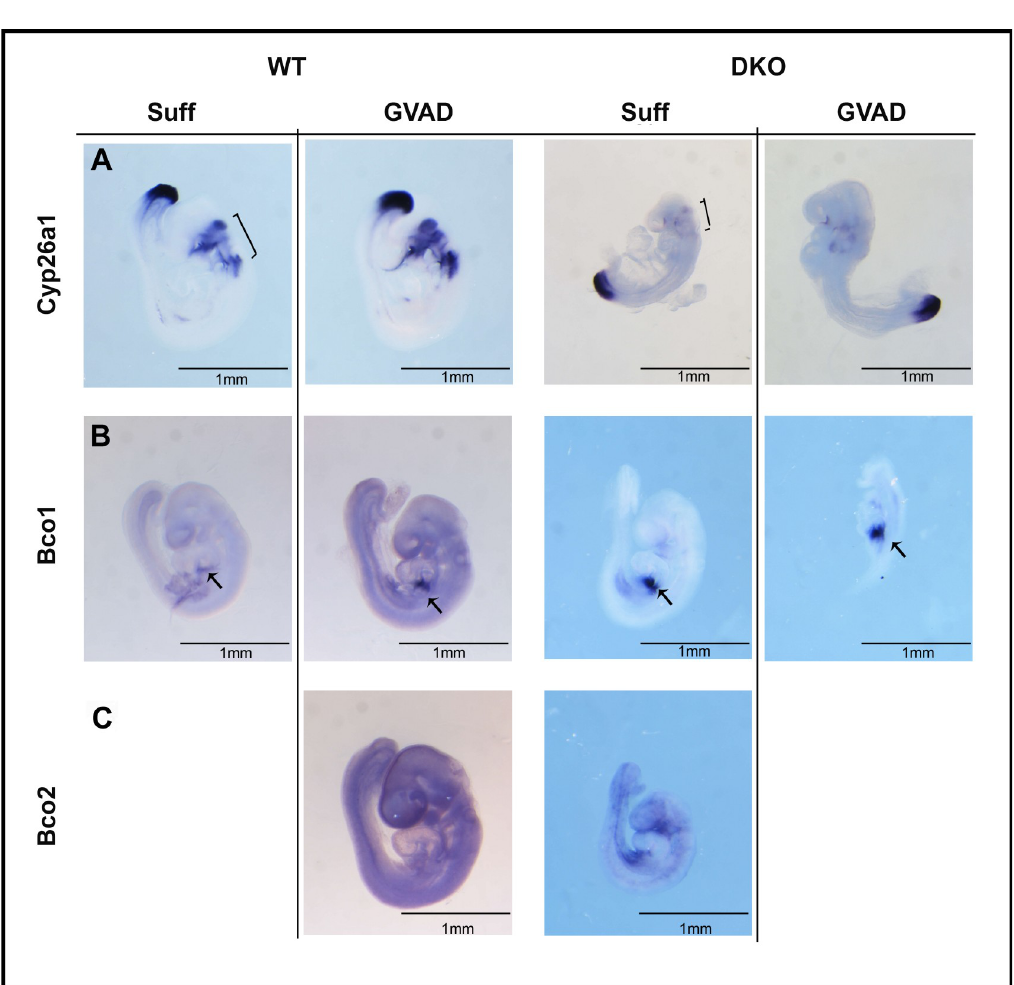
Fig 8. Effect of DKO and GVAD on E9.5 whole-mount ISH expression of genes associated with retinoid metabolism. E9.5 WT or DKO embryos from dams administered Suff or GVAD diets were probed by ISH for Cyp26a1 (A), and β -carotene metabolizing genes: Bco1 (B) and Bco2 (C). All images are shown to the same scale. For each, only the lateral view is shown. Hindbrain (bracket) and foregut presumptive liver (arrow) structures are noted. Bco1 staining was much stronger than Bco2 .